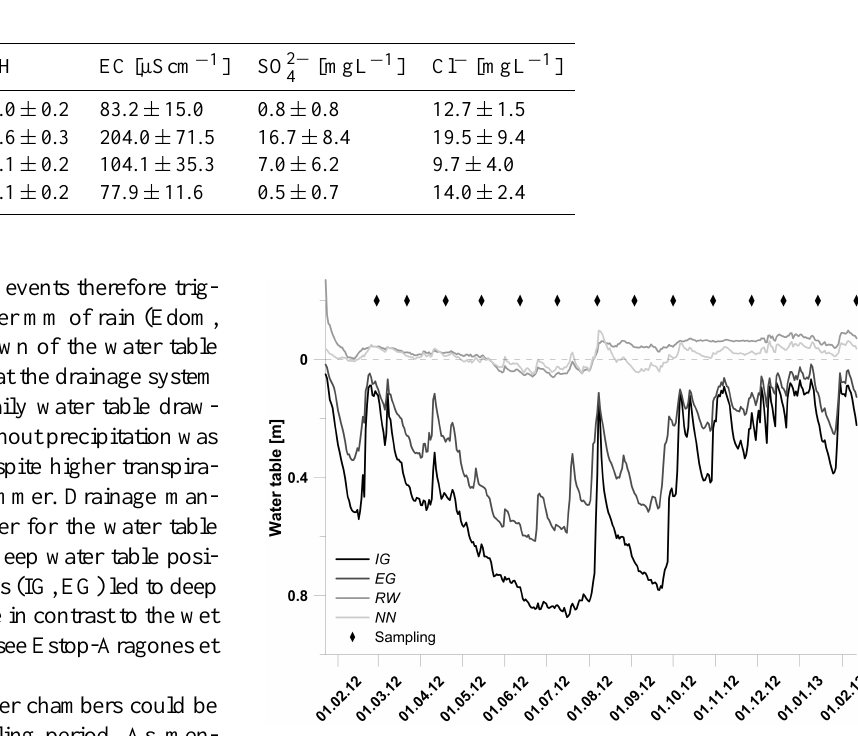
) and chloride (Cl − ) of the soil solution 4